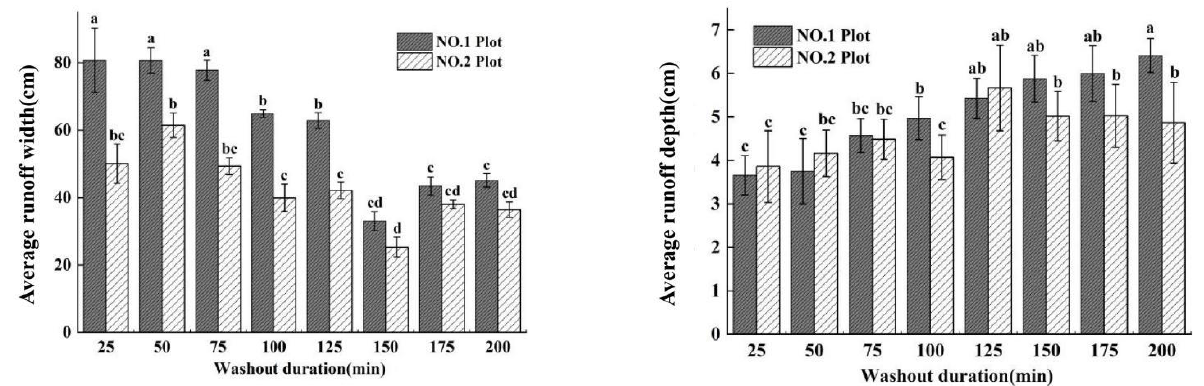
Figure 4. The changes in average runoff width and depth of short-term heavy rainfall (No. 1 plot) and moderate rainfall (No. 2 plot), with washout duration increasing. Note: The same letter on the histogram indicates no significant difference, and different letters indicate significant differences ( p < 0.05). The same applies below.